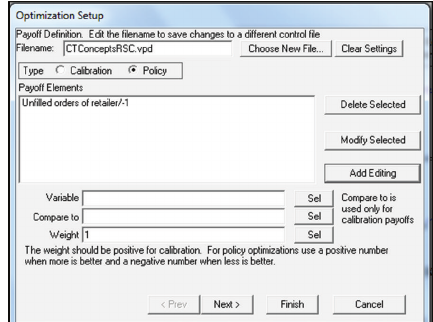
Figure 6: Selecting the payoff elements for optimization—objective is to minimize unfilled orders at the retailer.